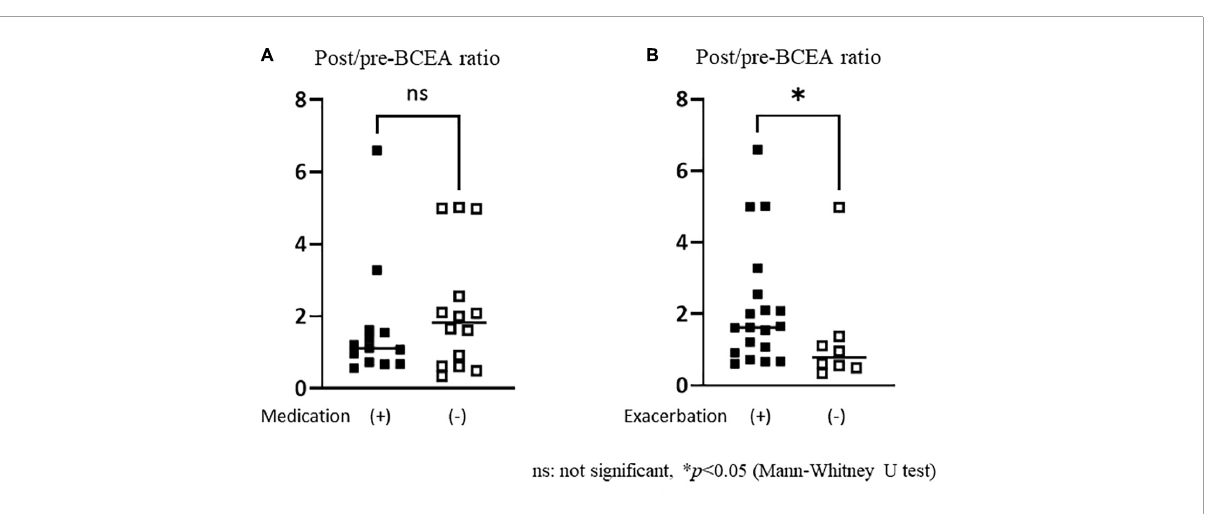
FIGURE5 Comparisons of the post/pre-bivariate contour ellipse area (BCEA) ratios in persistent postural-perceptual dizziness patients with or without antidepressant medication and exacerbation of dizziness sensation. (A) There was no significant difference in the BCEA ratio between the groups with and without antidepressant medication. (B) The post/pre-BCEA ratio was significantly greater in the group with exacerbation of dizziness sensation [median: 1.63, IQR (interquartile range): 1.64] than in the group without (median: 0.79, IQR: 0.80, p = 0.029, r =